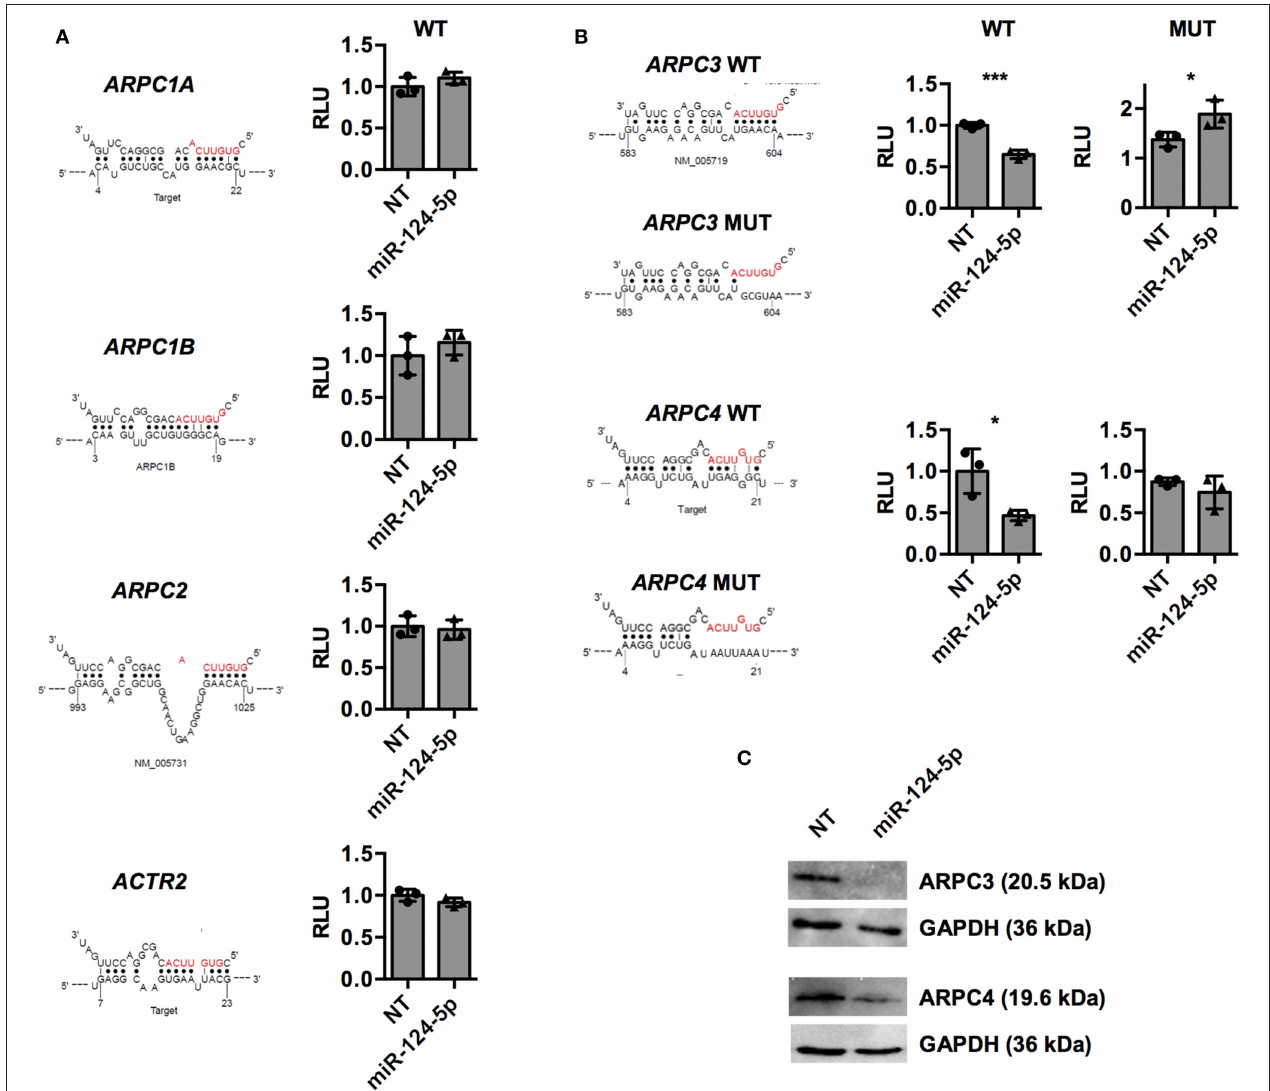
FIGURE 7 | Dual luciferase assays indicate that miR-124-5p directly binds to predicted target sequences in ARPC3 and ARPC4 and reduces corresponding protein levels in PMA-activated THP-1 M 8 . (A,B) Relative Renilla luciferase activity in HEK293 cells co-transfected with miR-124-5p or NT siRNA and dual luciferase reporter plasmids with predicted wildtype (WT) binding sequences in the ARPC1A , ARPC1B , ARPC2 , ARPC3 , ARPC4 , and ACTR2 mRNAs. (B) For binding sites of genes ARPC3 and ARPC4 yielding reduced relative luminescence units (RLUs) indicating direct interaction with miR-124-5p, additional dual luciferase reporter plasmids with mutated (MUT) binding sequences were tested. Values are RLUs of the firefly luciferase normalized for transfection efficiency using the constitutive Renilla luciferase activity. Statistical analysis was performed using Student’s t -test (* p < 0.05 ; *** p < 0.001). (C) Western blot for ARPC3 or ARPC4 protein levels. One representative blot of n = 3 independent experiments is